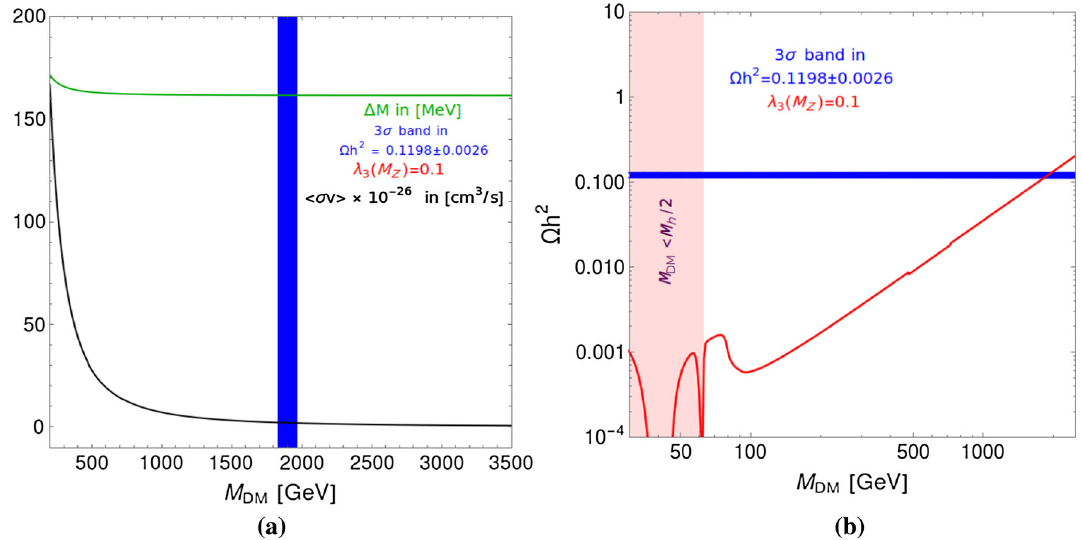
massfortheportalcoupling λ 3 ( M Z ) = 0 . 10. b Therelicdensity (cid:19) h 2 as a function of the DM mass M DM ( ≡ M H ) (red line) for λ 3 ( M Z ) = 0 .